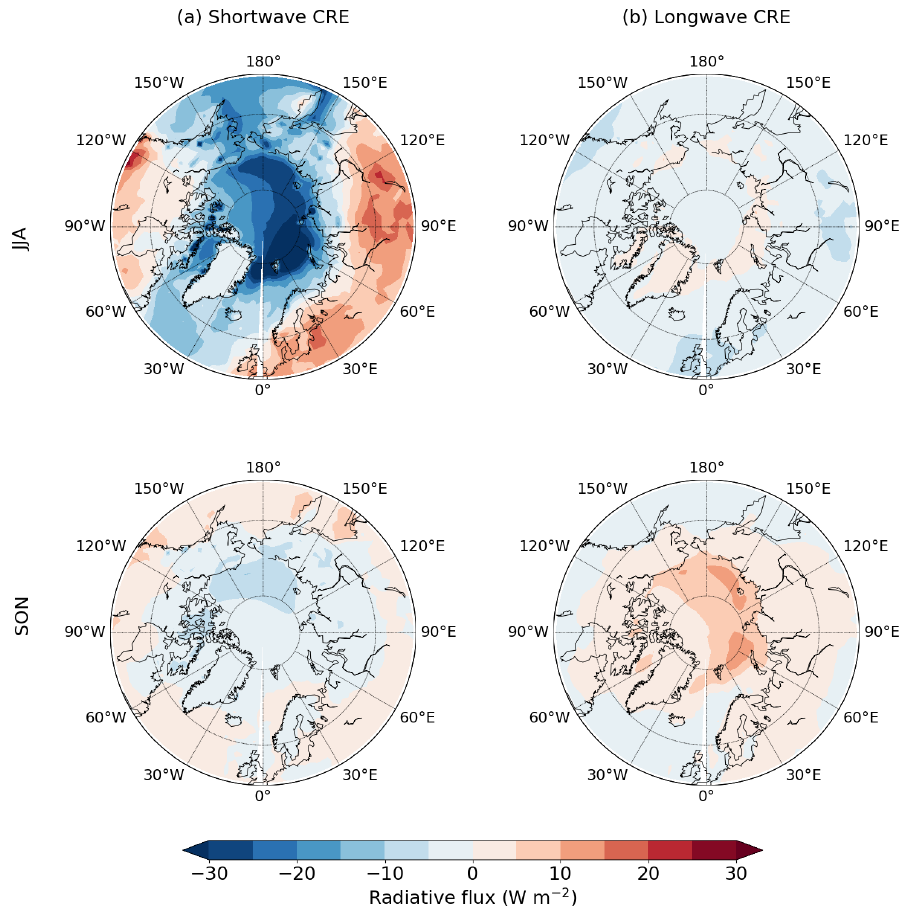
Figure 11. Summer (JJA) and autumn (SON) LIG–PI anomalies of (a) the shortwave cloud radiative effect (SW CRE) and (b) the longwave cloud radiative effect (LW CRE). All radiative fluxes are in Wm − 2 .